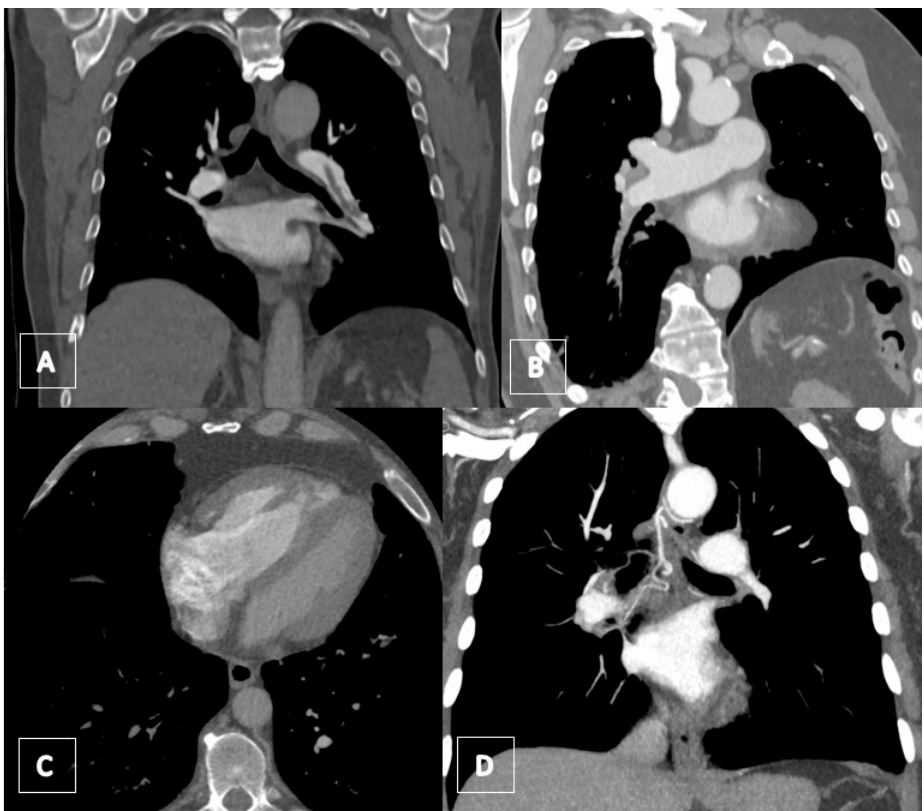
Figure 15. ( A ) Coronal CT image showing the free-floating embolus in the dilated pulmonary artery of the lower lobe surrounded by contrast agent. ( B ) Coronal CT image showing a chronic obstruction of the pulmonary artery of the right lower lobe with stricture of the vessel. ( C ) Axial CT image with contrast showing a right heart hypertrophy with thickened myocardium (>4 mm). RV/LV ratio is >1. ( D ) Coronal CT image demonstrating a dilated bronchial artery.